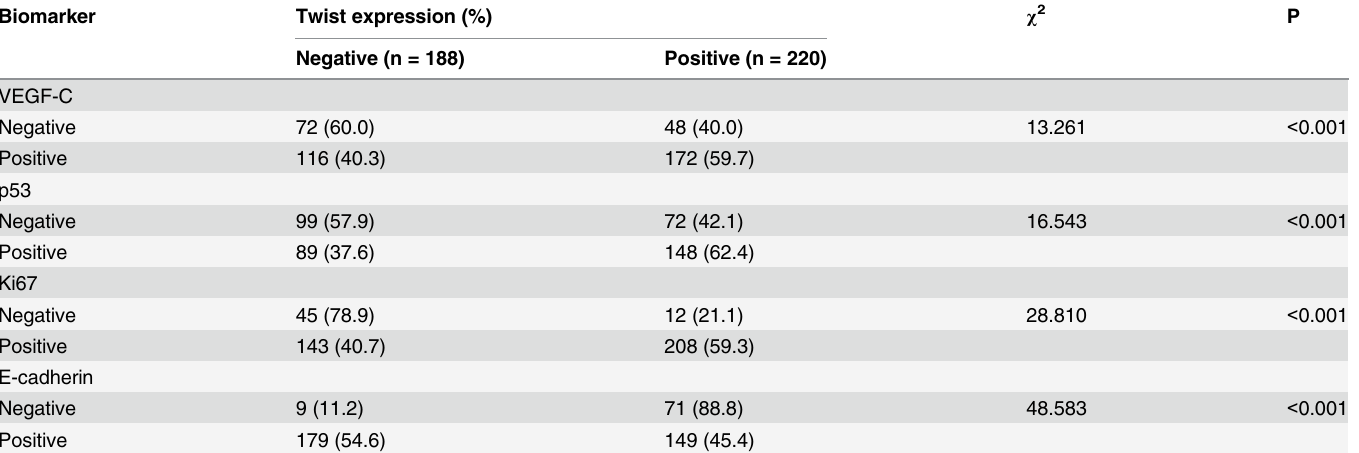
Table 3. Association of Twist expression with other molecules in breast cancer